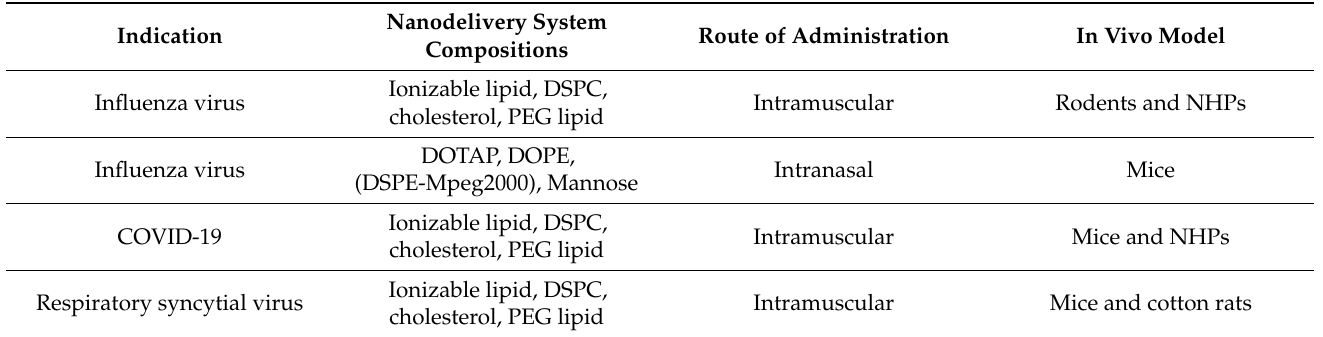
Table 2. Recent lipid nanoparticle delivery systems for mRNA-based